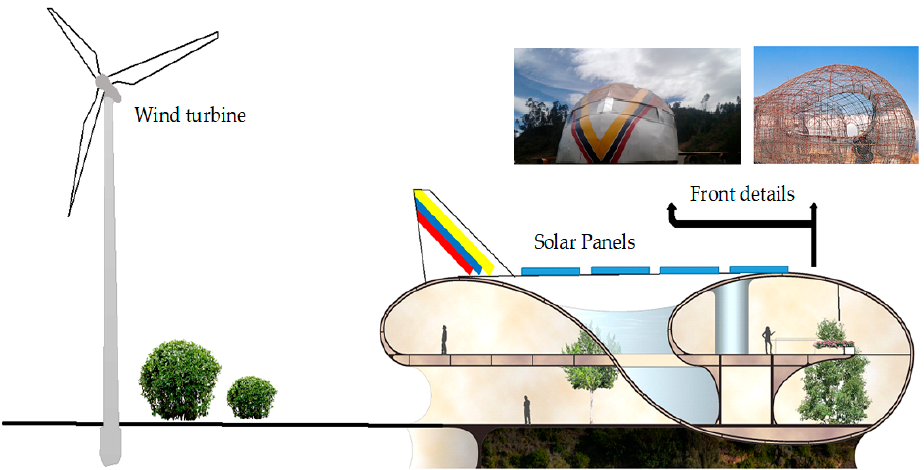
Figure 19. General scheme of organic airplane-type construction supplied by a hybrid renewable energy system.